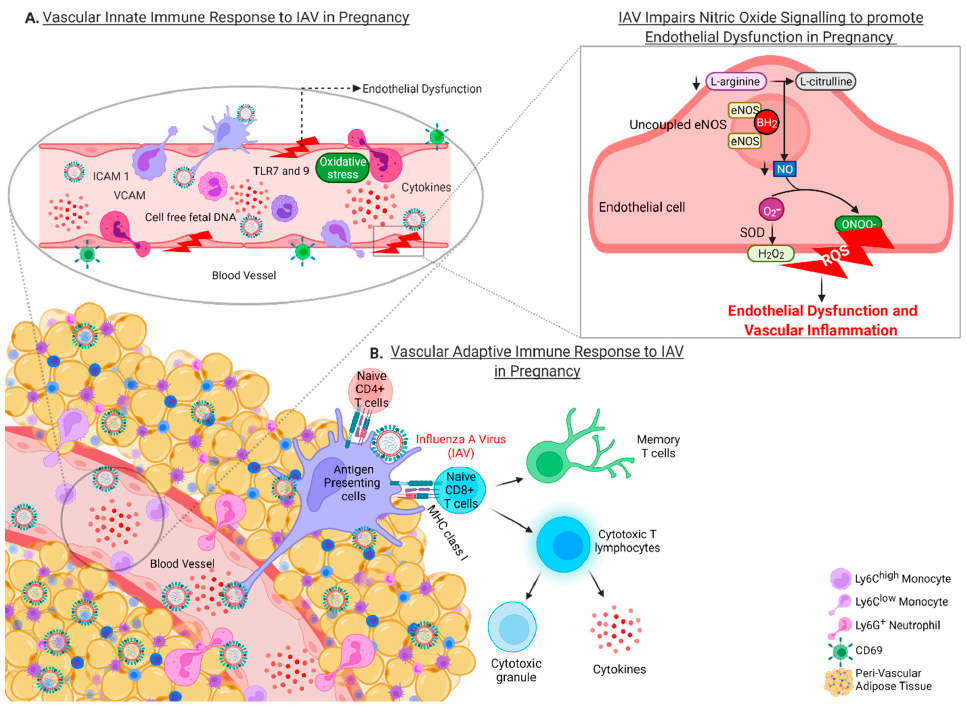
Figure 4. Schematic summary diagram depicting the vascular innate and adaptive immune re- sponse to Influenza A virus (IAV) infection in pregnancy. Following IAV dissemination from the lungs preferentially to the perivascular adipose tissue (PVAT) and then the vessel wall during preg- nancy, the virus is sensed by single stranded RNA (ssRNA) toll like receptor 7 (TLR7) leading to the initiation of the “vascular storm” innate and adaptive immune response. The innate immune re- sponse is characterised by an increase in the recruitment of patrolling Ly6C low , pro-inflammatory Ly6C high and Ly6G + neutrophils to the vessel wall and the PVAT and in the process induces endo- thelial dysfunction and vascular inflammation. Pro-inflammatory cytokines and IAV triggers the maturation of antigen presenting cells (APCs) mainly in the PVAT to promote the adaptive immune